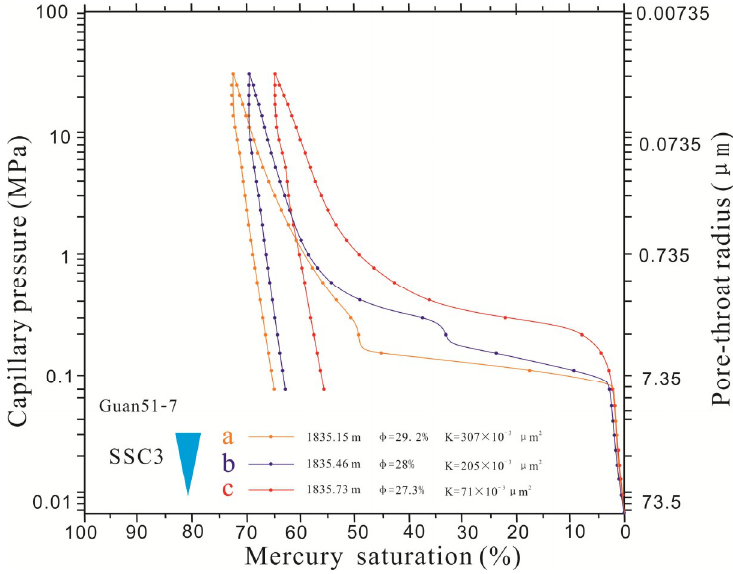
Figure 10. Intrusion and extrusion curves of PMI test of the samples in SSC3 (Well Guan51-7).